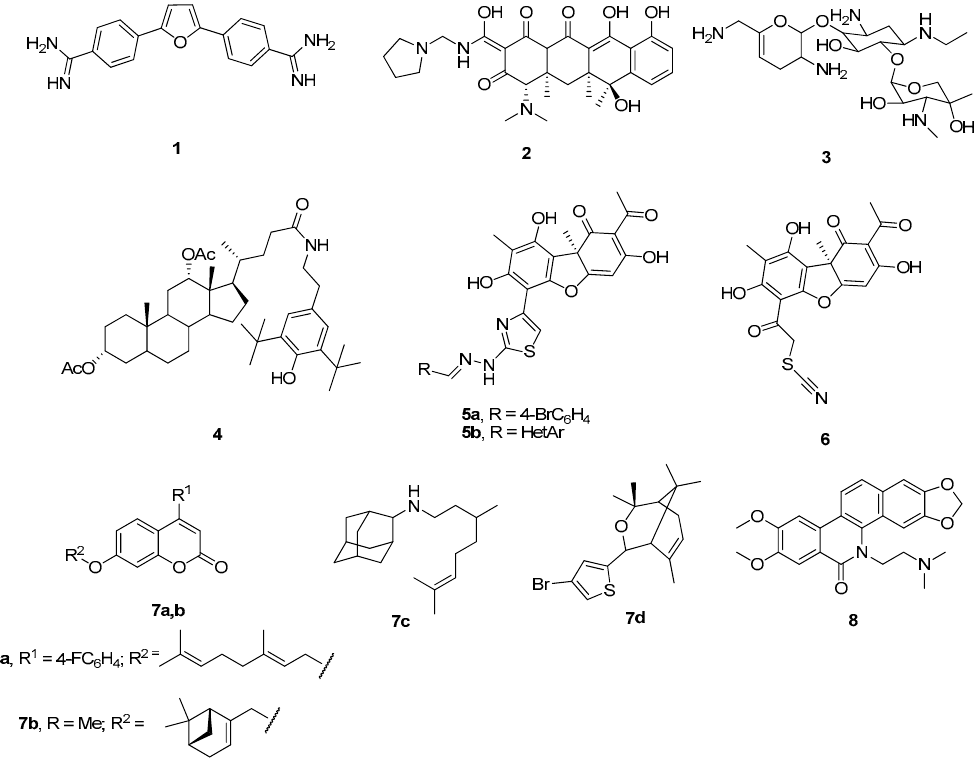
Figure 2. Examples of established Tdp1 inhibitors 1 – 8 .